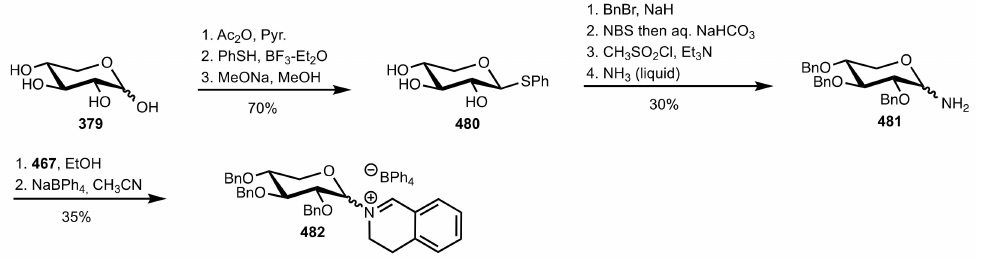
Scheme 124. The synthesis of the sugar iminium organocatalyst 482 .